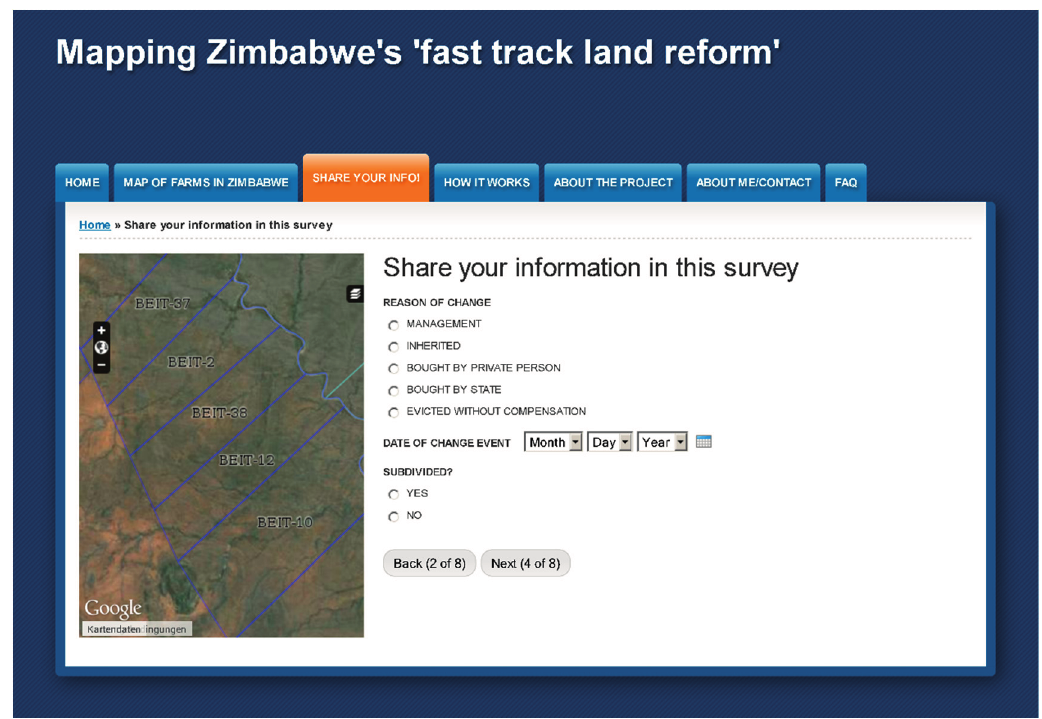
Figure 2. Screenshot of mapping